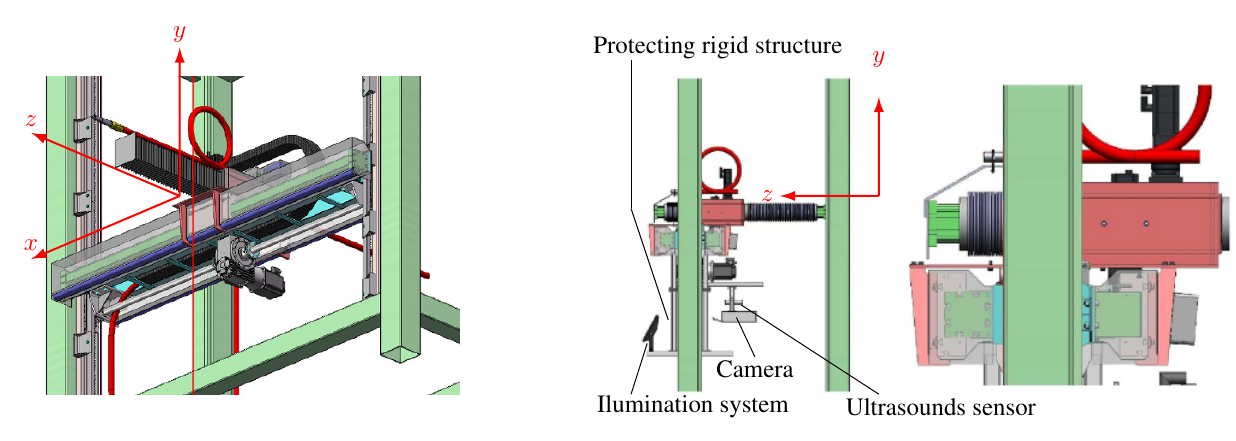
Figure 15. A CAD diagram of the new secondary